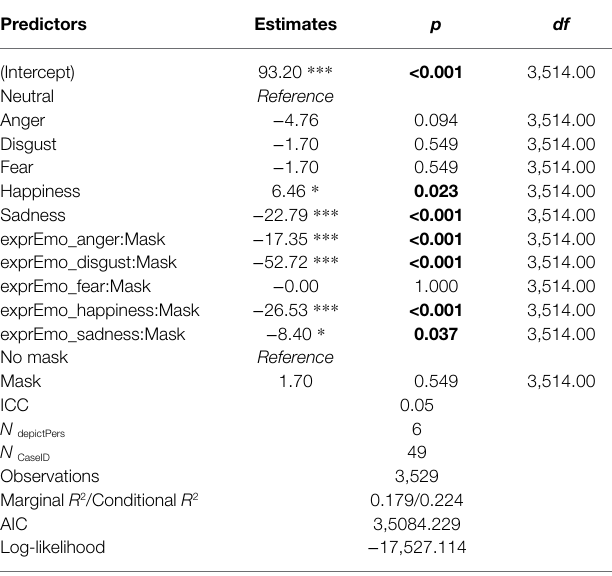
The table shows the statistics for all involved fixed effects in the linear mixed effects analysis for Model 5, regarding the tested dependent variable % correct (percentage of correct emotion classifications). Abbreviated notations for the terms were used to save space: exprEmo_XY = facial emotion, e.g., anger; Mask = face with face mask. Significant values of p are in bold. * p < 0.05 and *** p <